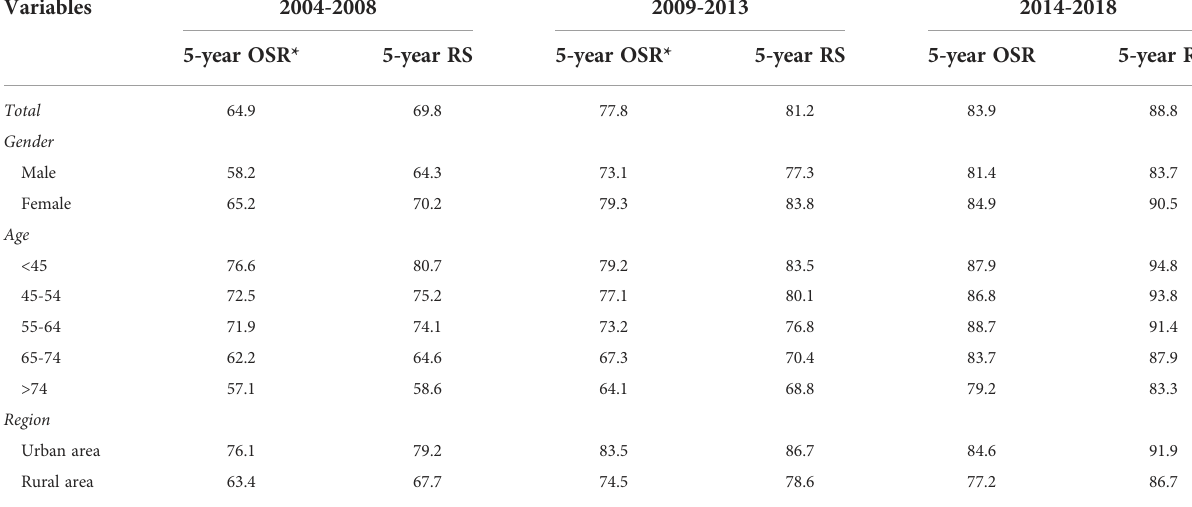
TABLE 3 Patient survival of breast cancer by sex, age at diagnosis and geographic region in Taizhou City (2004-2018). Variables